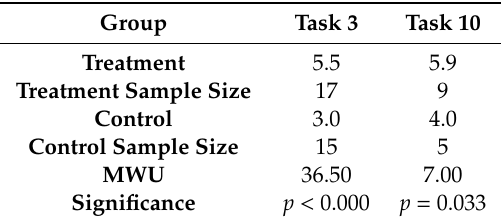
Table 8. Geographic location tasks